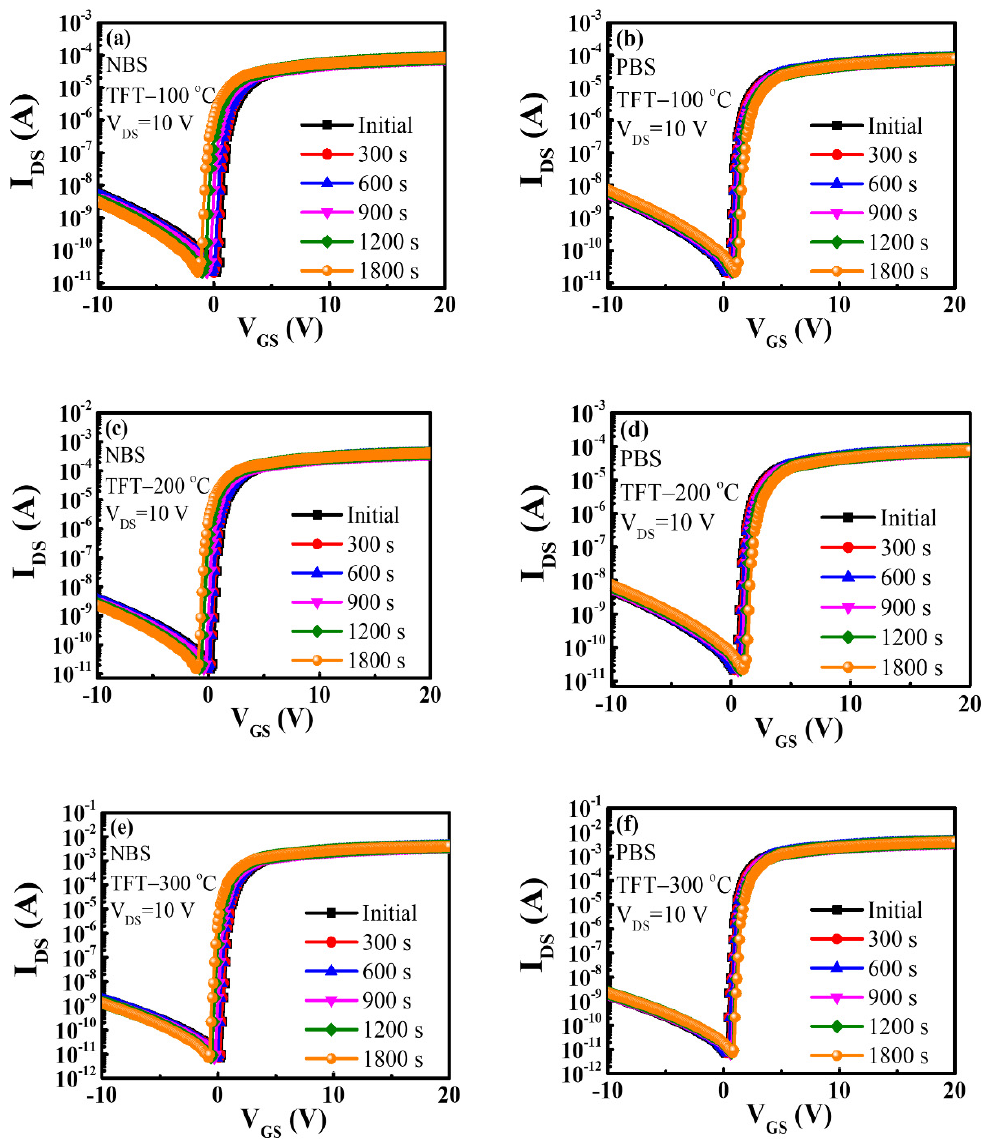
Figure 8. Evolution of transfer characteristics of DG IGZO TFTs with negative bias stress of − 10 V for TFTs annealed at ( a ) 100 °C, ( c ) 200 °C, and ( e ) 300 °C and with positive bias stress of 10 V for TFTs annealed at ( b ) 100 °C, ( d ) 200 °C, and ( f ) 300 °C, respectively.